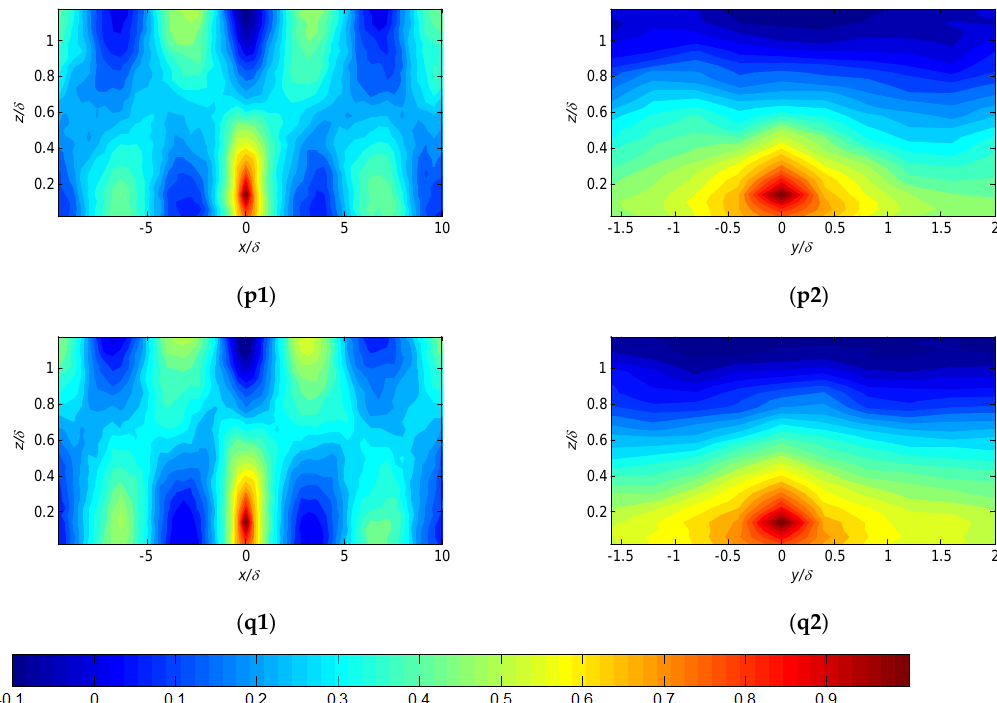
Figure 4. Contours of the two-point correlation of streamwise velocity fluctuations. Subfigures ( a1 ) to ( q2 ) means: each row represents case 1 to 17, from very stable, to neutral, and then very unstable conditions, with the left and right columns showing the contours in the xz and yz planes, respectively.